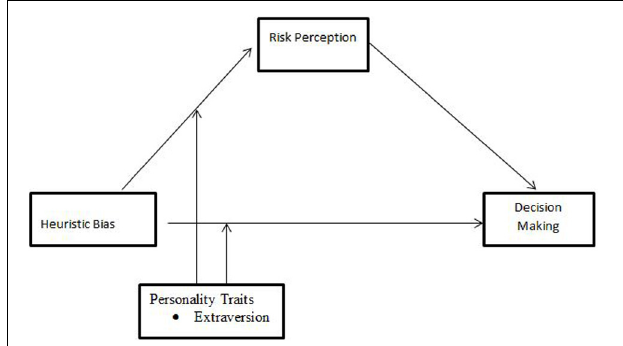
FIGURE 1 | Conceptual